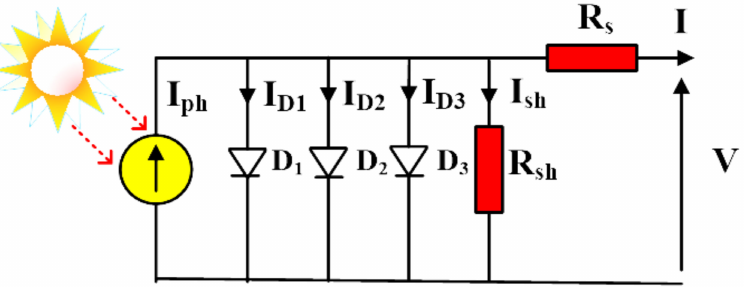
Figure 1. The equivalent circuit of